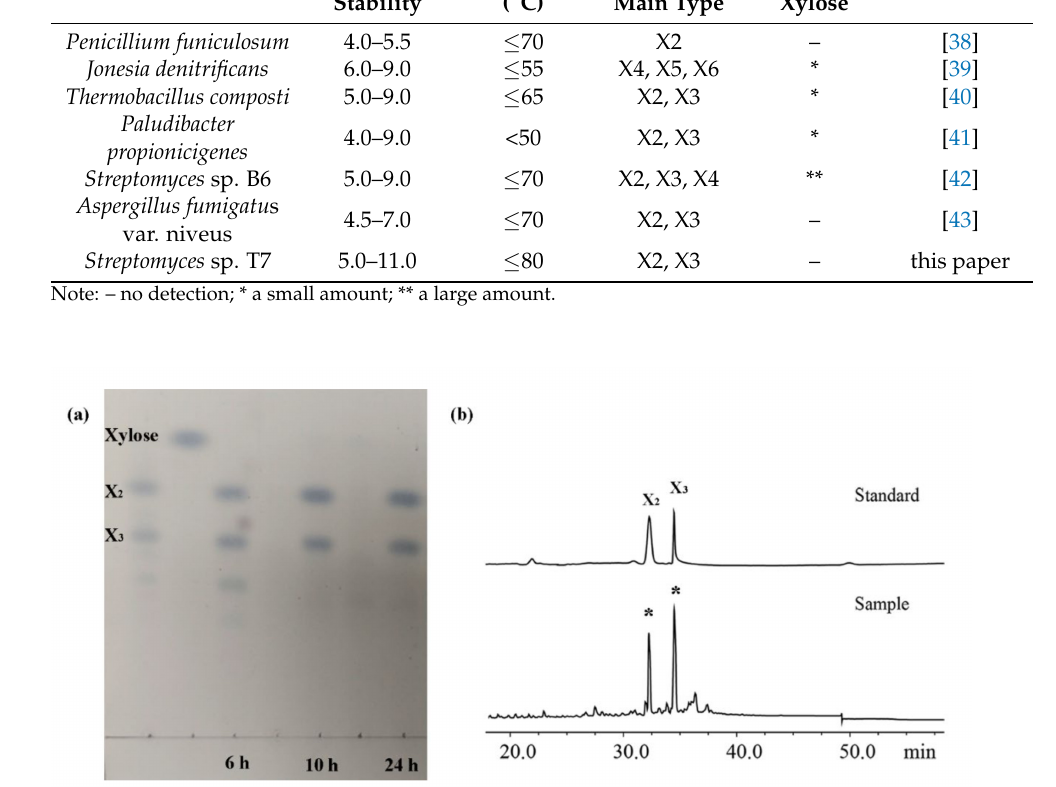
Figure 7. TLC ( a ) and HPLC ( b ) analyses of hydrolysate products. X2 and X3 represent xylobiose and xylotriose, respectively. Note: 6 h, 10 h, and 24 h represent hydrolysate products after 6, 10, and 24